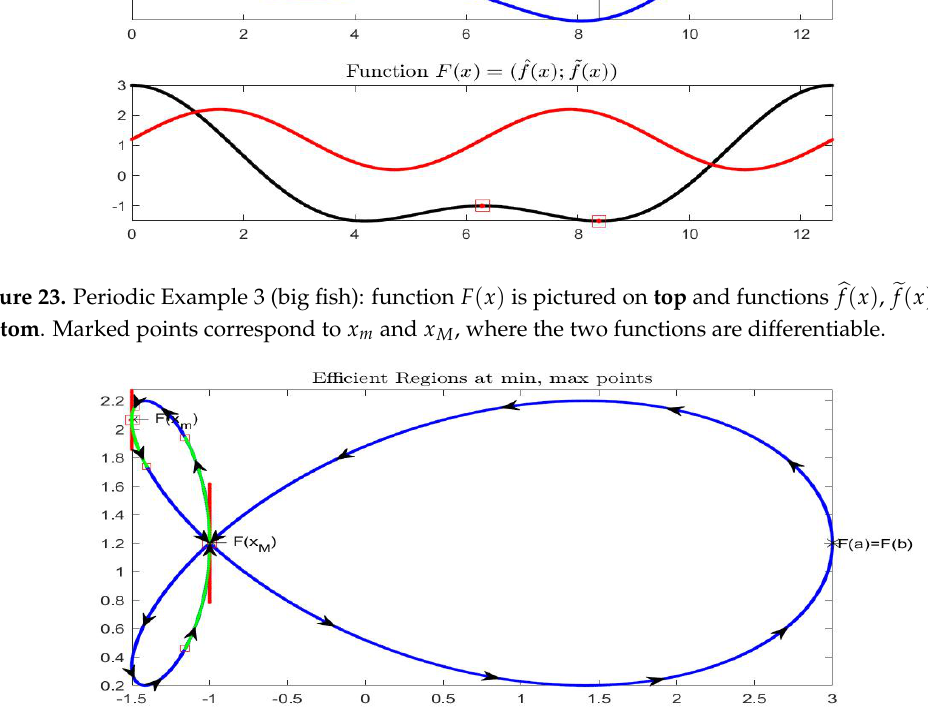
Figure 24. Periodic Example 3 (big fish): midpoint representation of function F ( x ) ; marked points are F ( x m ) and F ( x M ) and the efficient E min ( F ; x m ) and E max ( F , x M ) sets of points are marked in green